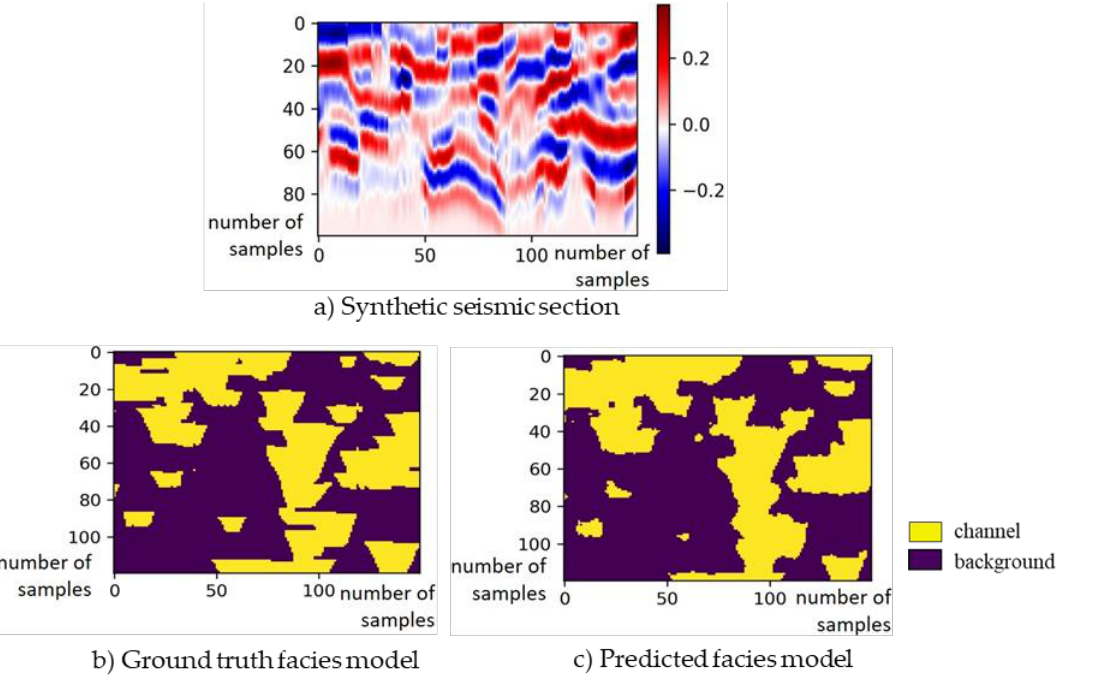
Figure 10. Synthetic seismic section ( a ), ground truth facies model ( b ) and predicted result ( c ). 92% accuracy indicates that the architecture is viable and can be applied to the real datasets.